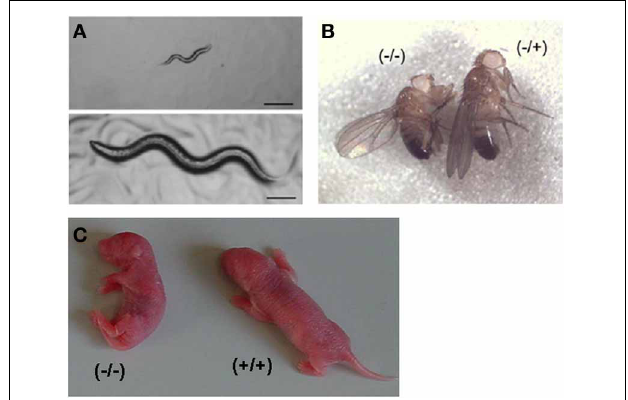
FIGURE 5 | Developmental delay in peroxisome deficient animals. (A) Developmental arrest of C. elegans at the L1/L2 stage by Pex5 RNAi (top panel), compared to wild type nematode (bottom panel), being photographed 3 days after being laid. Bar, 10 μ m. Reproduced/adapted with permission from Thieringer et al. (2003). (B) Reduced body size and weight of an adult male homozygous pex16 1 fruitfly compared to heterozygous animal. Taken from Nakayama et al. (2011). (C) Appearance of newborn mice pups, showing severe hypotonia and growth delay in a Pex5 − / − pup compared to a wild type